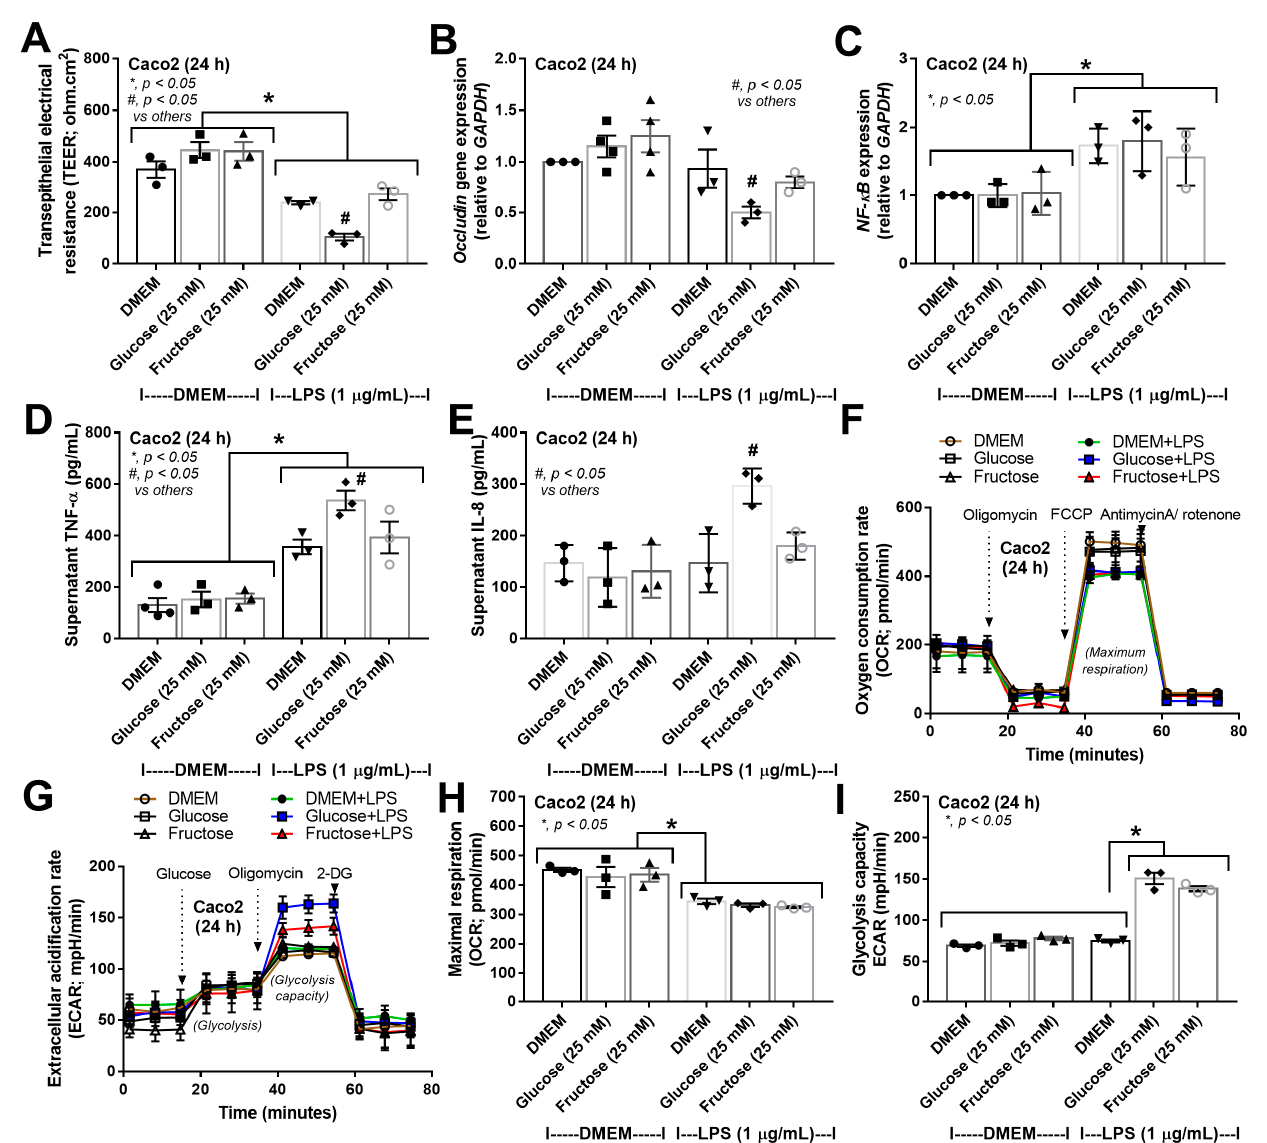
Figure 6. Characteristics of Caco-2 cells (enterocytes) after 24 h of activation by medium control (DMEM), glucose or fructose with and without lipopolysaccharide (LPS) as indicated by transep- ithelial electrical resistance (TEER) ( A ), occludin gene expression (a tight junction molecule) and nuclear factor kappa B ( NF- κ B; a transcription factor) ( B , C ), supernatant cytokines (TNF- α and IL-8) ( D , E ), the extracellular flux analysis of mitochondrial function and glycolysis activity through oxygen consumption rate (OCR) and extracellular acidification rate (ECAR), respectively, ( F , G ), and the graph presentation of maximal respiration from OCR ( H ), and glycolysis capacity of ECAR ( I ) are demonstrated. Independent triplicate experiments were performed for all experiments.